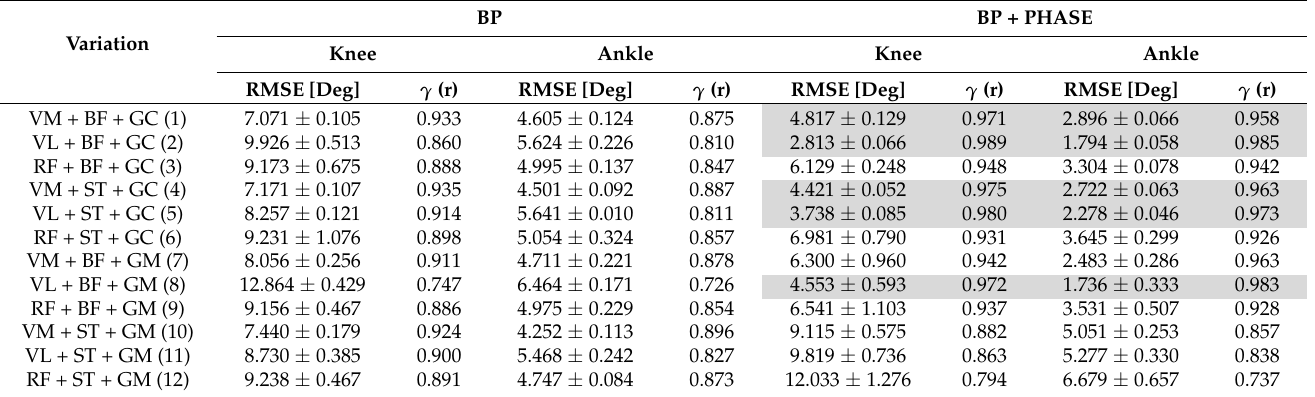
Table 3. The comparison of three muscle combinations for the subject AB14.